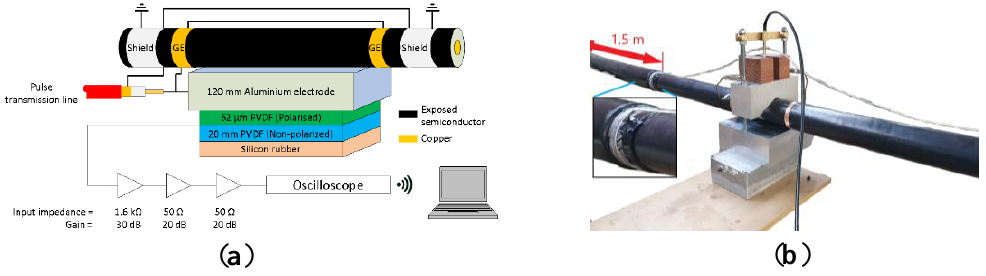
Figure 2. ( a ) Representation of the PEA test cell including the acoustic sensor, amplifier and oscilloscope. GE stands for guard electrode. The sizes of the components are not to scale. ( b ) PEA test cell setup. The acoustic sensor consists of a 52 µ m thick polyvinylidene fluoride (PVDF) piezo film,